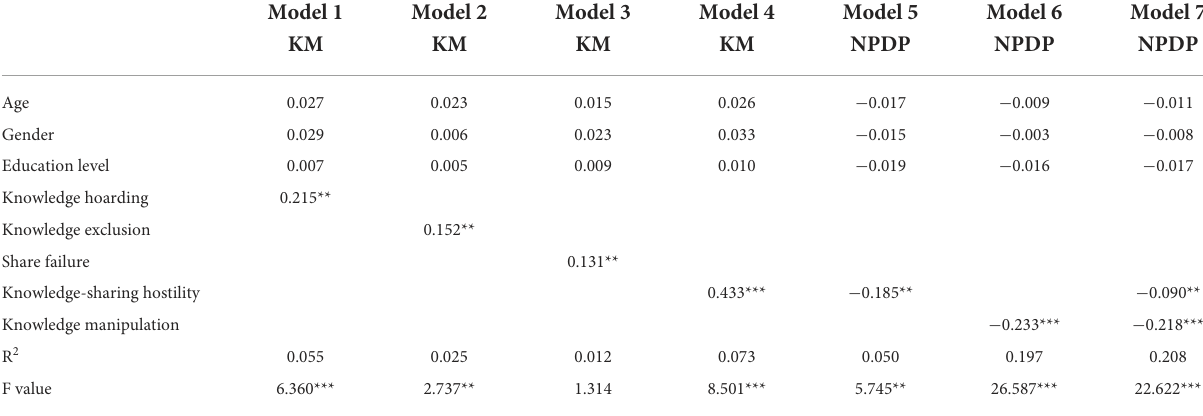
TABLE 4 Relationship between knowledge-sharing hostility and knowledge manipulation and new product development